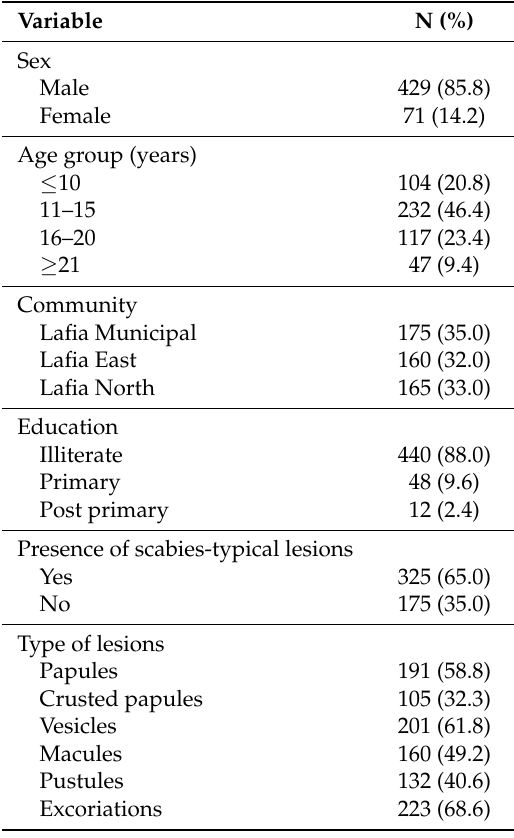
Table 1. Characteristics of study population ( n =